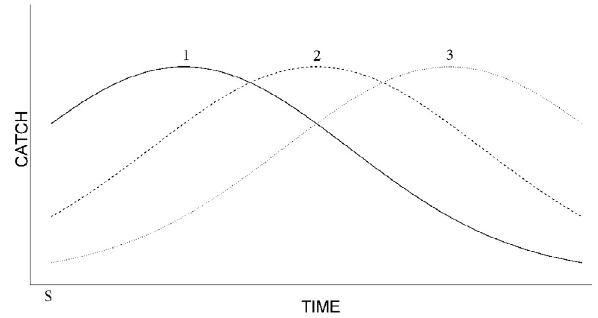
Fig. 3. – Types of rates of catch decrease from the peak during a fishing season. I=1, slow; I=2, intermediate; and I=3, rapid. S is the month when the fishing season starts (Rocha et al.